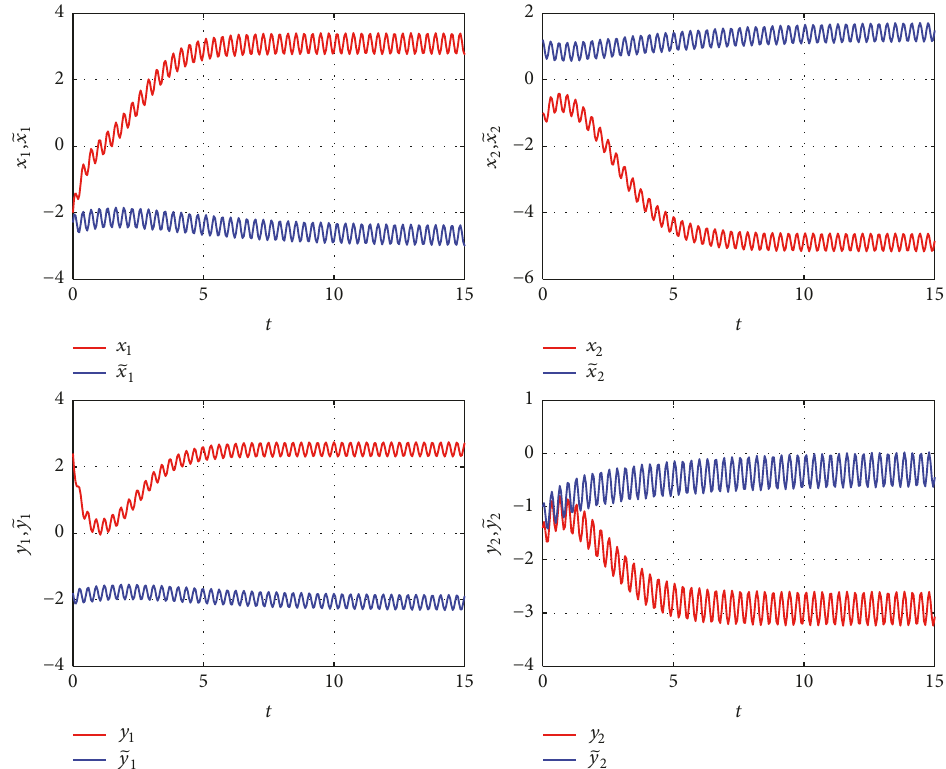
Figure 2: Time responses of real and imaginary parts of the variables 𝑧 1 , 𝑧 2 , ̃𝑧 1 , and ̃𝑧 2 without controller for example